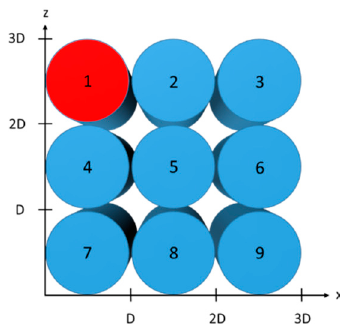
Figure 11. Rate of heat generation in the battery module.